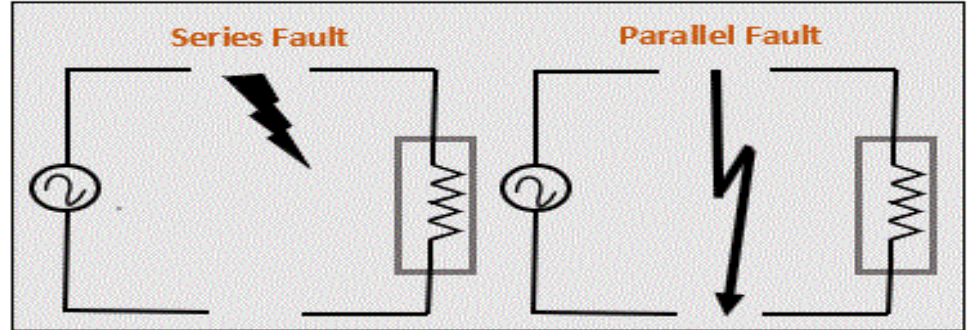
Figure 15. Electrical arc fault classification.